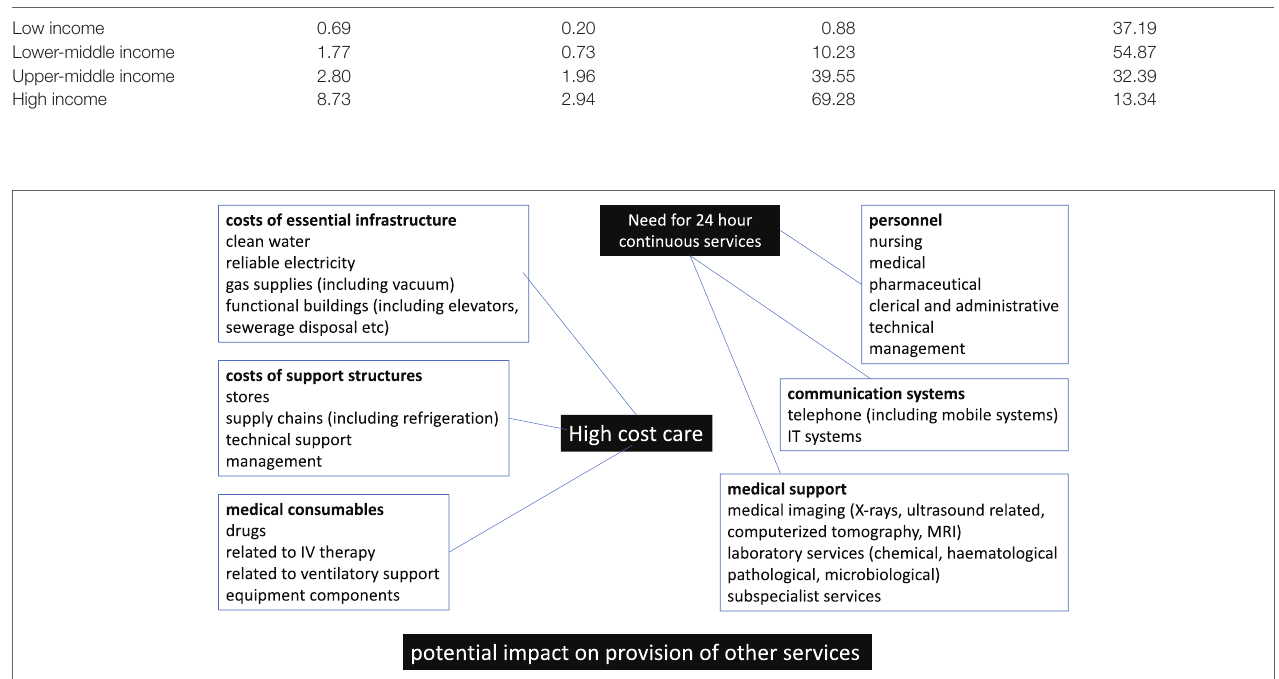
FiGURe 1 | Components of the costs related to high-cost care (HCC) in low- and middle-income countries and low-income